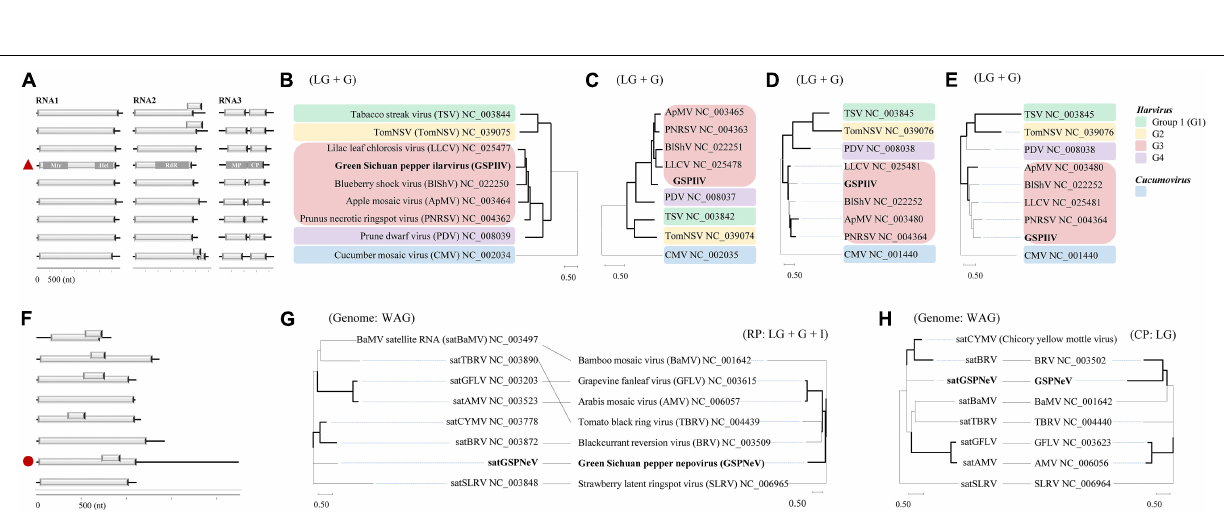
FIGURE 1 | Virome analysis of Z. armatum trees affected with the flower yellowing disease and the trees without obvious symptoms. Proportion of reads associated with the viral and subviural RNAs, relative to total reads of each symptomatic sample (A) , and asymptomatic/healthy sample (B) , and reads of evolution-associated RNAs, i.e., two RNAs of green Sichuan pepper-nepovirus (GSPNeV) with green Sichuan pepper-nepovirus large linear satellite RNA (satGSPNeV), two RNAs of green Sichuan pepper-idaeovirus (GSPIdV) or three RNAs of green Sichuan pepper-ilarvirus (GSPIlV), were counted together. Viral/subviral read number comparison between symptomatic and asymptomatic branch samples from the same tree, with three independent partial diseased trees analyzed (C) . In figures (A–C) , the colors of bars indicate different viruses, and satGSPNeV is shown the same color with GSPNeV. Heatmap of read numbers of viral and subviral RNAs from different samples, with the clustering of samples (D) ; the deeper the colors of bars (from blue to red), the higher the numbers of reads specific to each viral/subviral RNA. Flower plots indicate the numbers of common virus/satellite across the symptomatic (E) or asymptomatic/healthy (F) samples that are shown in the central blue circles or of specific virus/satellite in each sample that are shown in the petals; two viruses and one satellite were detected in all symptomatic samples that have been marked with D or DS, but no common virus/satellite was detected in asymptomatic/healthy samples that have been marked with DA or H. Green Sichuan pepper-enamovirus (GSPEV), and -nucleorhabdovirus (GSPNuV).